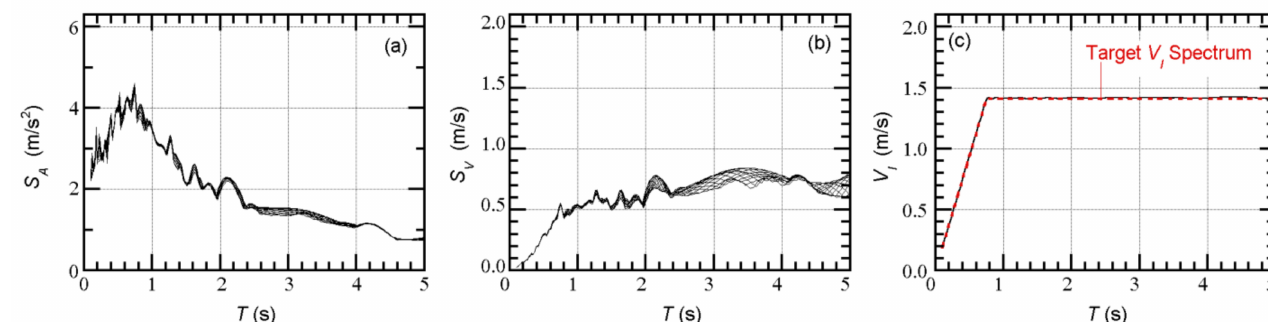
Figure 15. Horizontal response spectra of the artificial ground motion (Art-1 series): ( a ) Elastic acceleration response spectrum (damping ratio: 0.05); ( b ) elastic velocity response spectrum (damping ratio: 0.05); ( c ) elastic total input energy spectrum (damping ratio: 0.10).